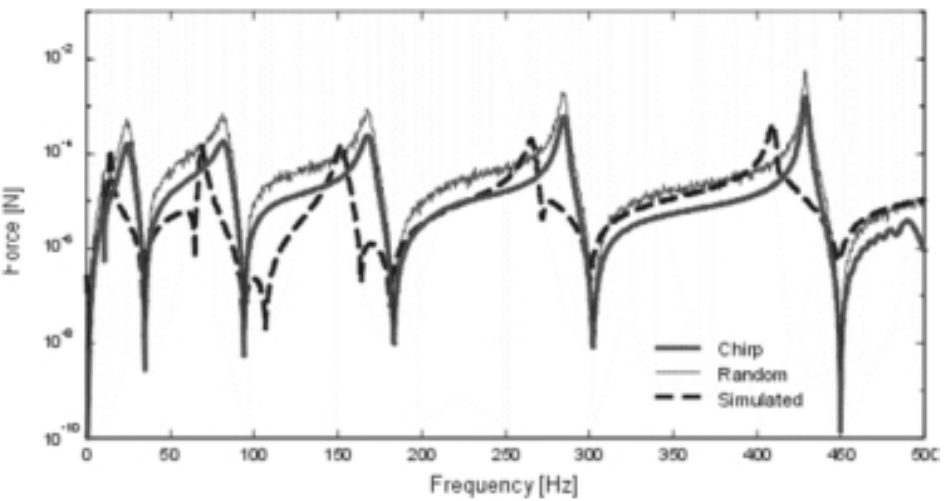
Fig. 12. Input force – current